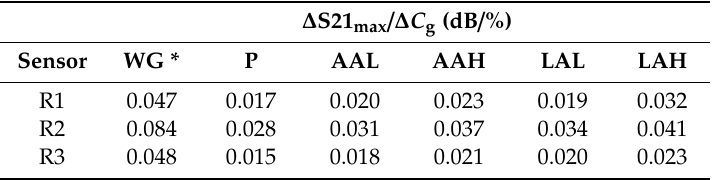
Table 6. Sensitivities of the sensors for all sets regarding S21 max . * Data from